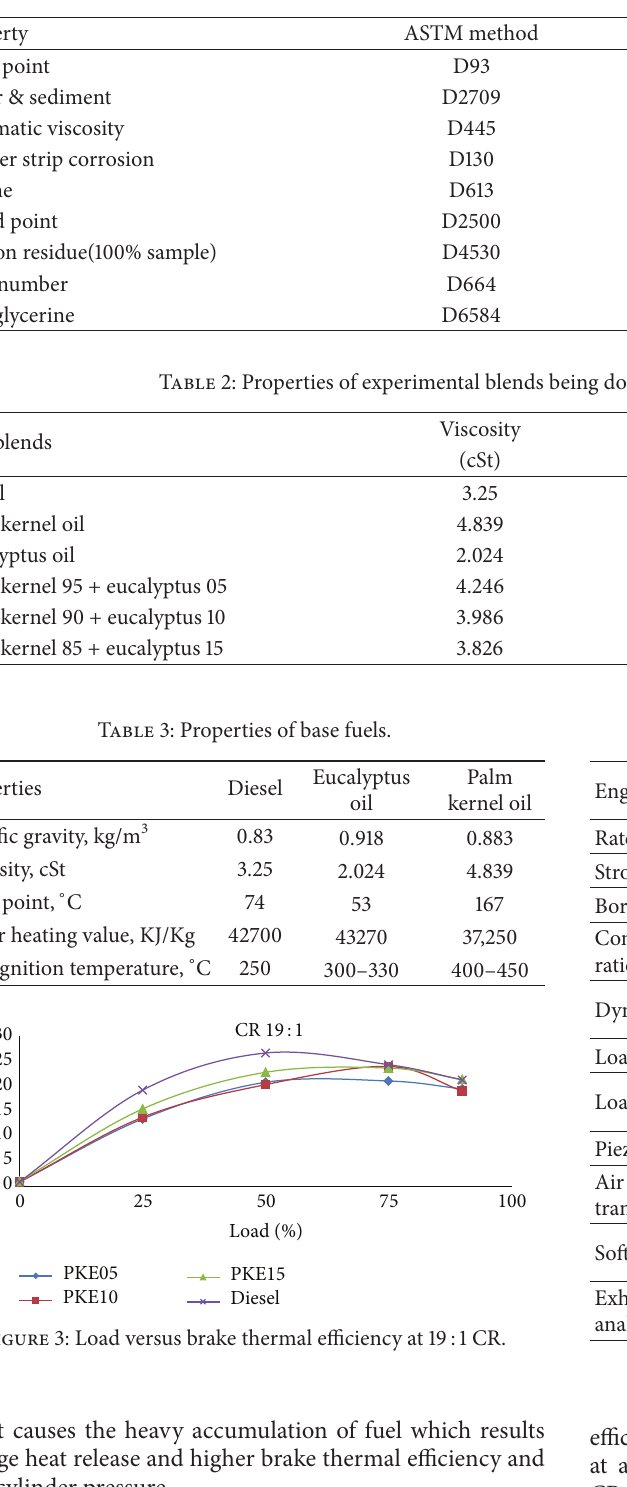
Table 1: ASTM specification (D6751) for biodiesel (B100).